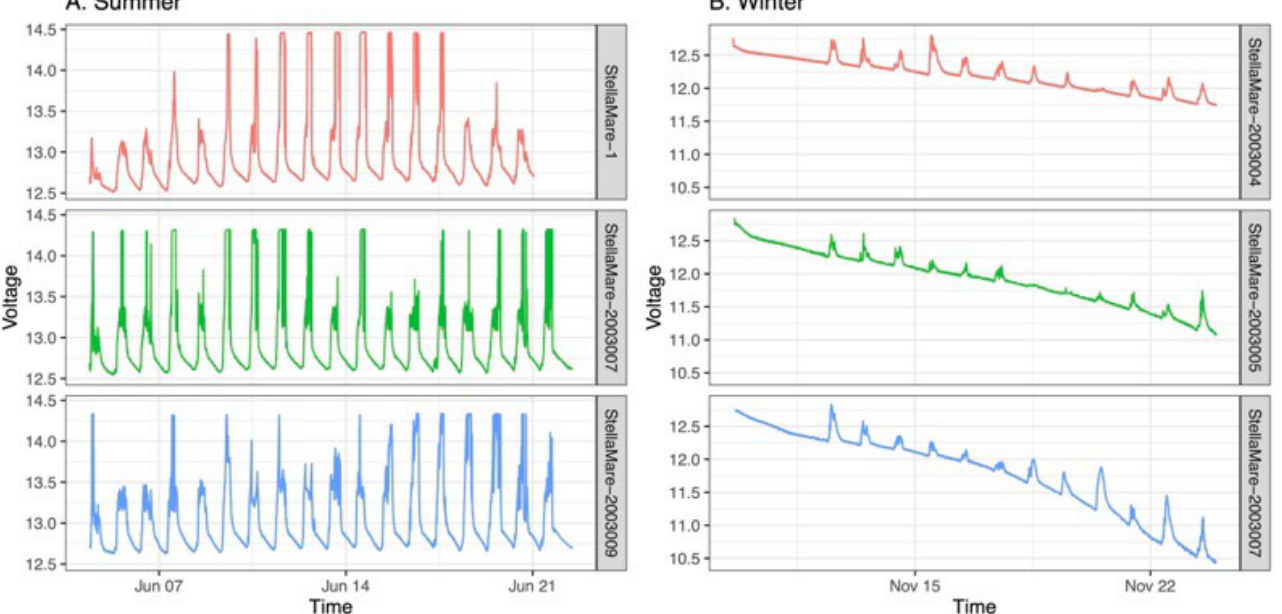
Figure 12. ( A ) Battery voltage plots of three acoustic receivers during summer experiments; ( B ) battery voltage plots of three acoustic receivers during winter experiments.